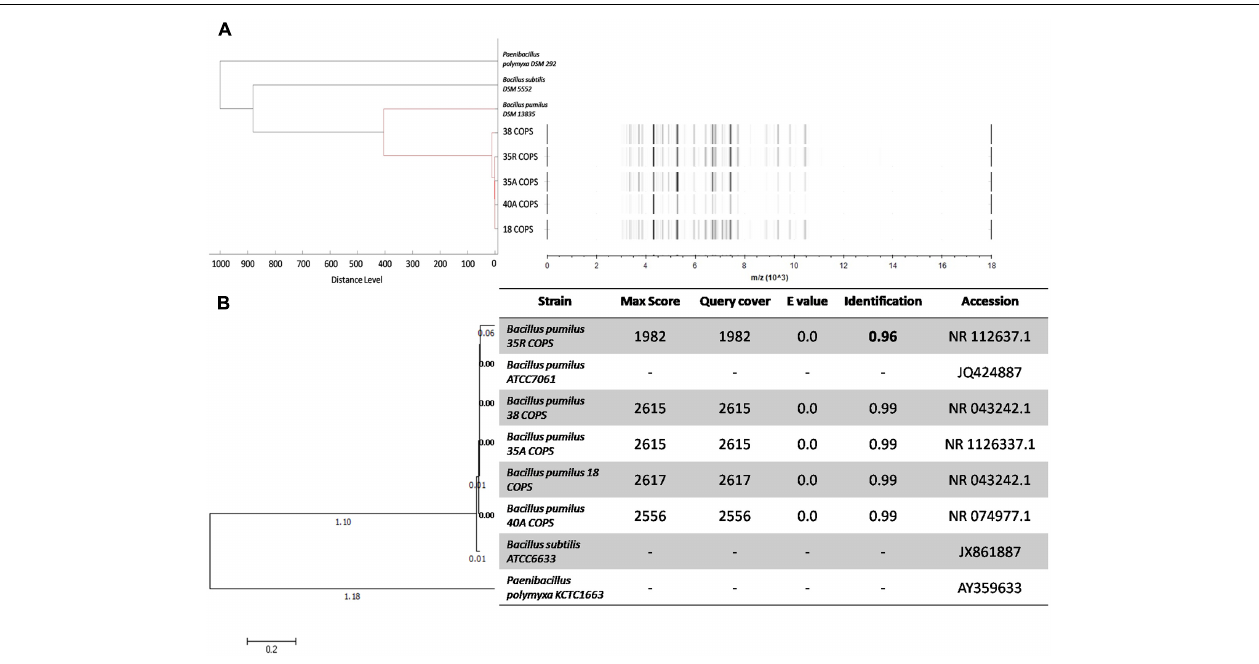
FIGURE 2 | Dendrogram and gel view MALDI-TOF mass spectra comparing the phylogenetic tree of 16S rDNA gene sequences and the phylogeny of Bacillus pumilus strains. (A) Dendrogram and gel view MALDI-TOF-MS profiles created by the Biotyper MSP Dendrogram Creation Standard Method, version 1.4 with default settings as follow: distance measure: correlation; linkage: –300, related-0. Out-grouping was performed with the reference strain B. pumilus DSM1382, B. subtilis DSM 5552 and Paenibacillus polymyxa DSM 292 (B) Neighbor-joining tree and table of alignment scores of 16S rDNA gene sequences of B. pumilus strains isolated from copepod eggs ( A. tonsa ) using the nucleotide (BLAST) software of NCBI tree generated using MEGA 7 software. Out-grouping was performed with the reference strain B. pumilus ATCC7061, B. subtilis ATCC6633 and Paenibacillus polymyxa KCTC 1663